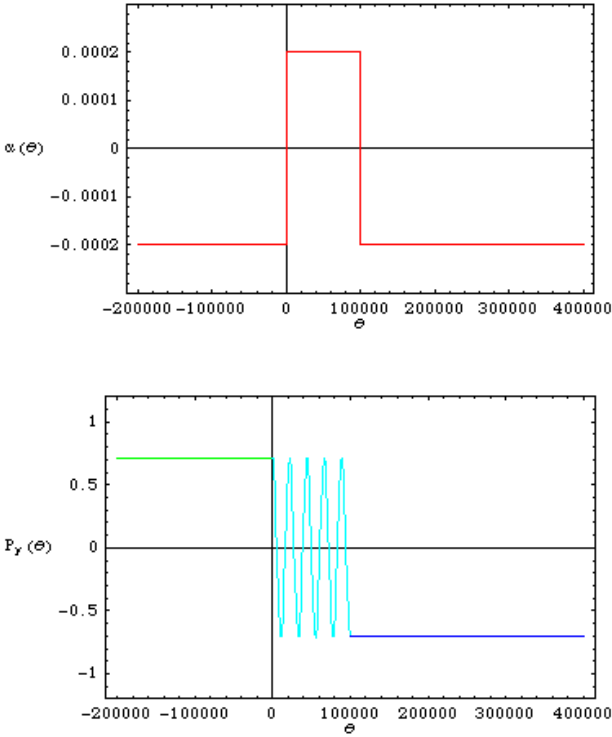
FIG. 4. (Color) Same as Fig. 3, except that j (cid:5) changed to become equal to A so that j (cid:5) The two jumps constructively interfere as the polarization makes complete oscillations during the time between the two jumps. 4 1 2 The final polarization after the second crossing is constant in time.